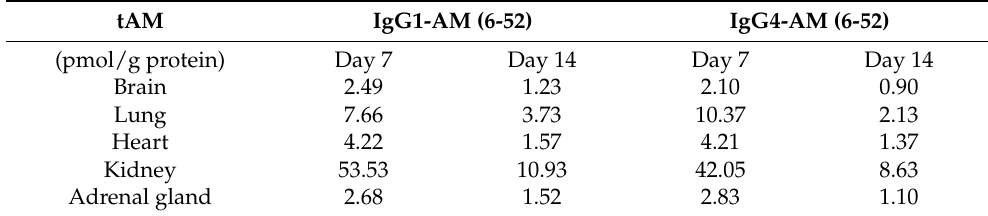
Table 2. The tissue levels of tAM were determined by enzyme